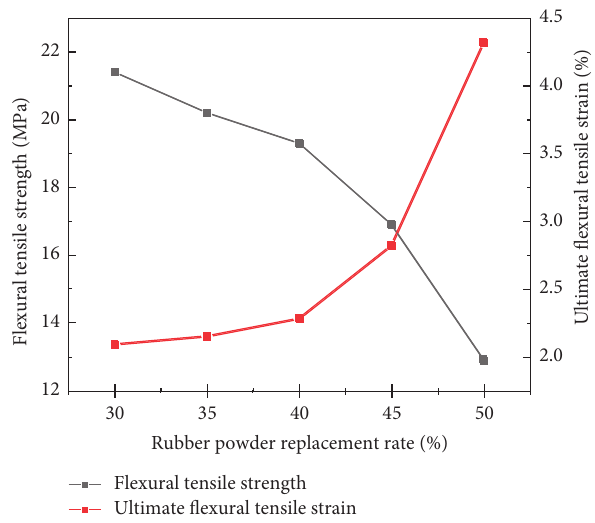
Figure 6: Relationship between rubber powder replacement rate and flexural tensile strength of concrete.